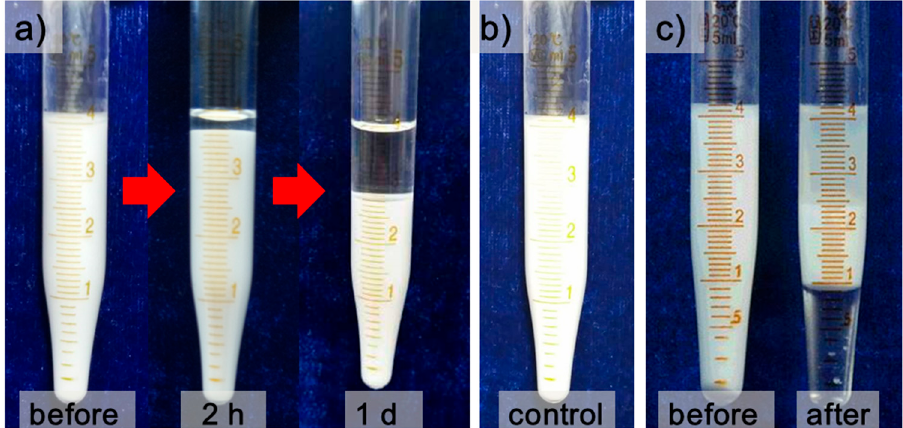
Figure 3. ( a ) Emulsion settling under gravity after 2 h and 24 h, ( b ) emulsion after passing a straight tube in an electric field and ( c ) emulsion before and after a single-pass demulsification with the